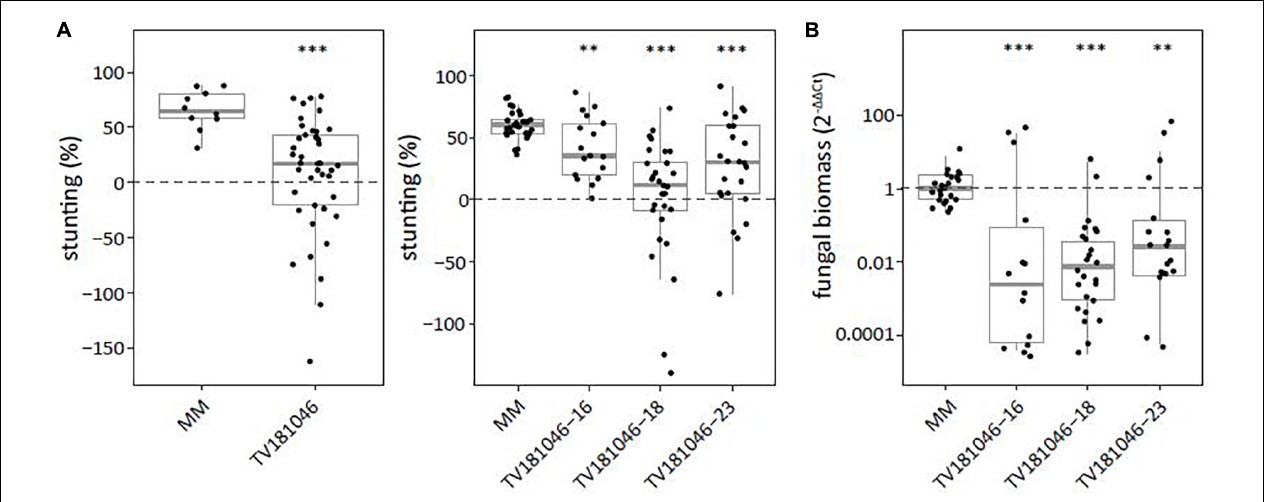
FIGURE 6 | Targeted knockout of SlWAT1 lead to loss of susceptibility to V. dahliae. (A) Stunting (%) of V. dahliae inoculated T2 (left) and T3 (right) plants when compared with the average stunting of mock-inoculated plants at 21 days post inoculation (dpi). Box plots represent data with n ≥ 9 plants per experimental repeat ( t -test when compared with MM with ∗∗ p < 0.01 and ∗∗∗ p < 0.001). (B) Fungal biomass of V. dahliae- inoculated T3 CRISPR plants of all three lines in stems at 21dpi. This was calculated as the ratio of the V. dahliae ITS gene amplification in comparison with the tomato reference SlRUB gene ( Supplementary Table 1 ) and normalized to V. dahliae- inoculated MM plants using 2 − (cid:49)(cid:49) Ct on a log10 scale with n ≥ 9 repeat per experimental repeat ( t -test on (cid:49) Ct when compared with MM with ∗∗ p < 0.01 and ∗∗∗ p <